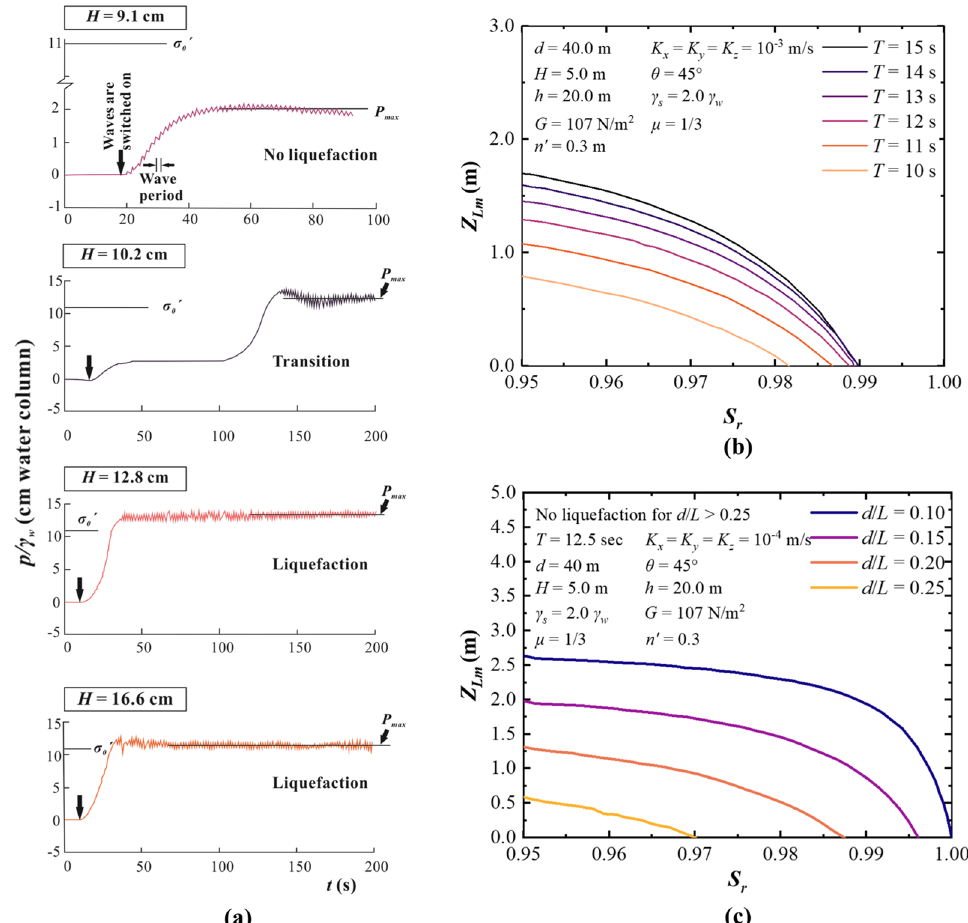
Fig. 10 Seabed liquefaction under different wave conditions: a wave height; b relative water depth; c wave period (modified from Jeng